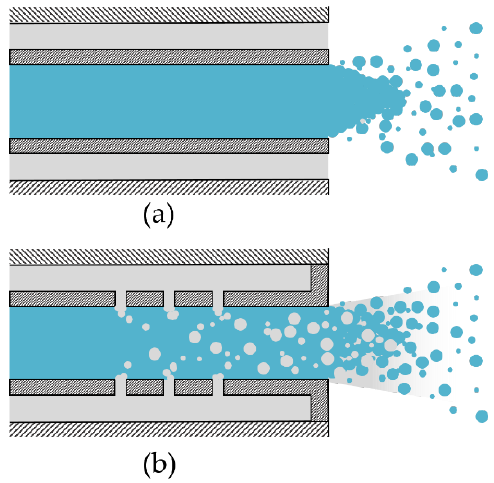
Figure 1. Atomization Principles. ( a ): Coaxial atomization: air and liquid mix at the outlet of the liquid tube (external mixing). ( b ): Effervescent atomization: air is bubbled into the liquid before ejection (internal mixing).